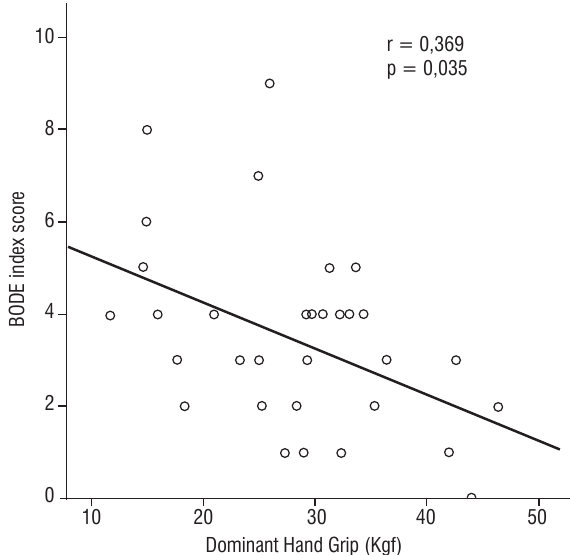
Figure 3 - Correlation between BODE index and Dominant Hand Grip. Table 2 - BODE index stratified by the Hand Grip dominant and non-dominant in patients with COPD Variables COPD. (n =